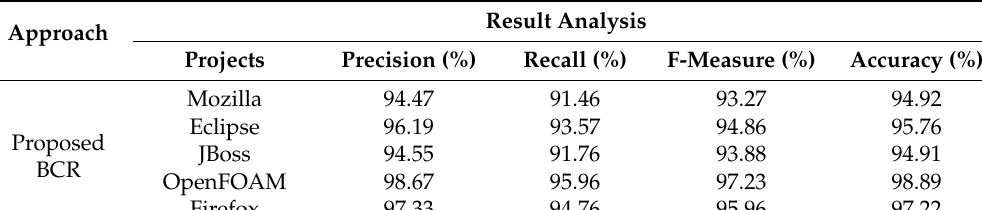
Table 3. The average result of all datasets.